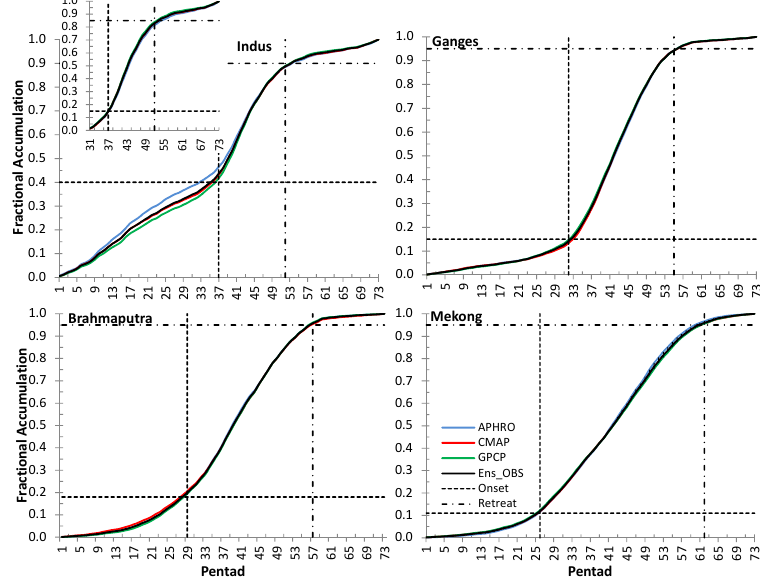
Figure 3. Fractional accumulated pentad precipitation from the observational datasets of GPCP, CMAP and APHRO along with their ensemble mean for Indus, Ganges, Brahmaputra and Mekong basins. Note: the pentads corresponding to realistic timings of monsoon onset and retreat timings around the middle of each basins are indicated with dashed lines. For Indus, the inset shows the fractional accumulation excluding January to May period of